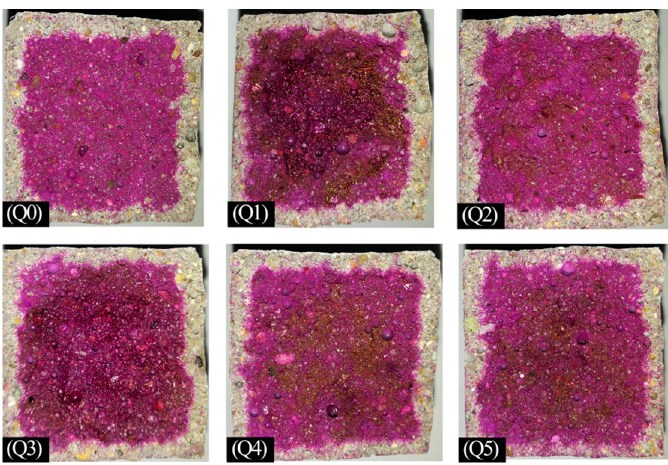
Figure 5. Image of carbonation depth under ultrasonic vibration agitation (3 d).